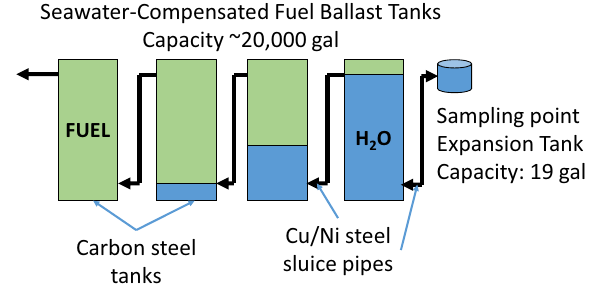
Fig. 6 Cartoon schematic of a seawater-compensated ballast tank group. In reality, a ballast tank group is formed by interconnected chambers of varying shapes and sizes. The expansion tanks are where seawater enters and exits the ballast system and where samples were obtained. Fuel enters the fi rst tank and pushes seawater through the rest of the tanks via the sluice